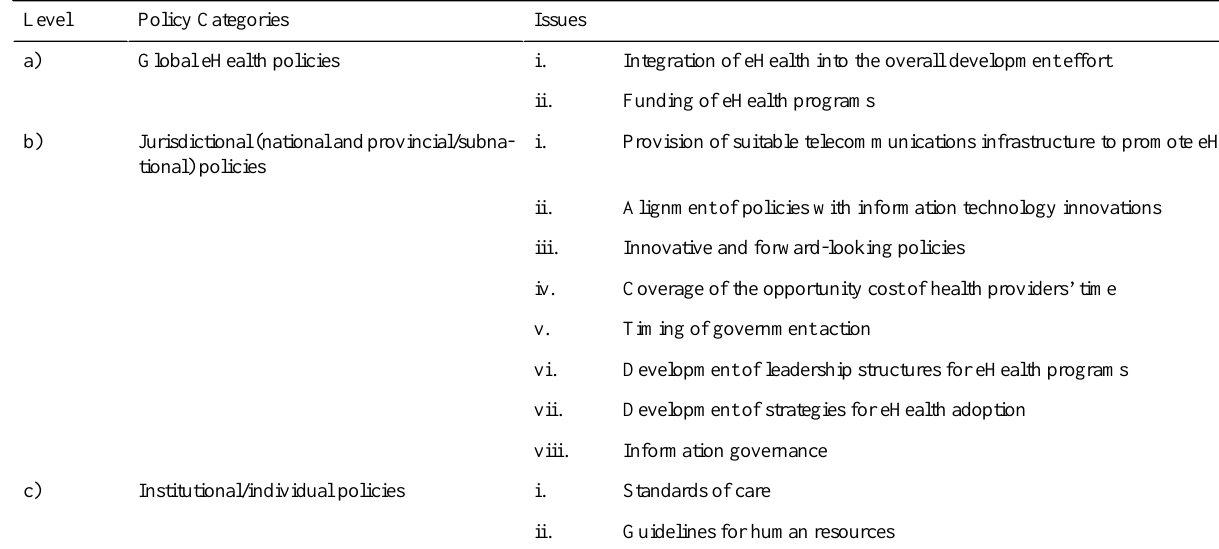
Table 6. Goal-setting for eHealth policy.